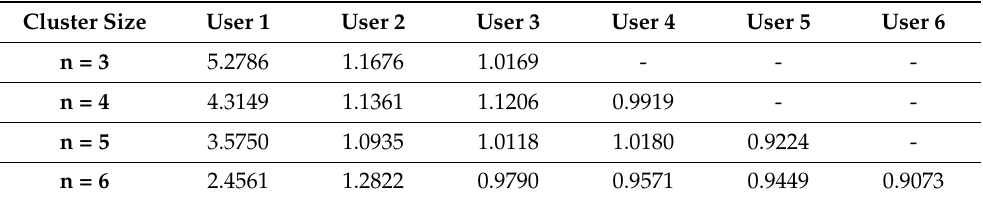
Table 7. Normalized IDR analysis in bits per sec per Hertz of Magic matrix-based power allocation [22] in downlink NOMA clusters without IRS.